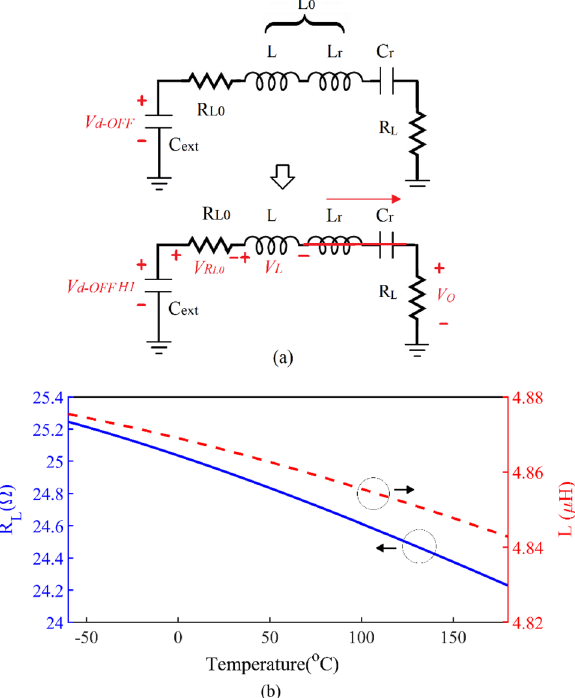
Figure 10. ( a ) The output resonant circuit in the main harmonic. ( b ) The R L and L for establishing ZVS and